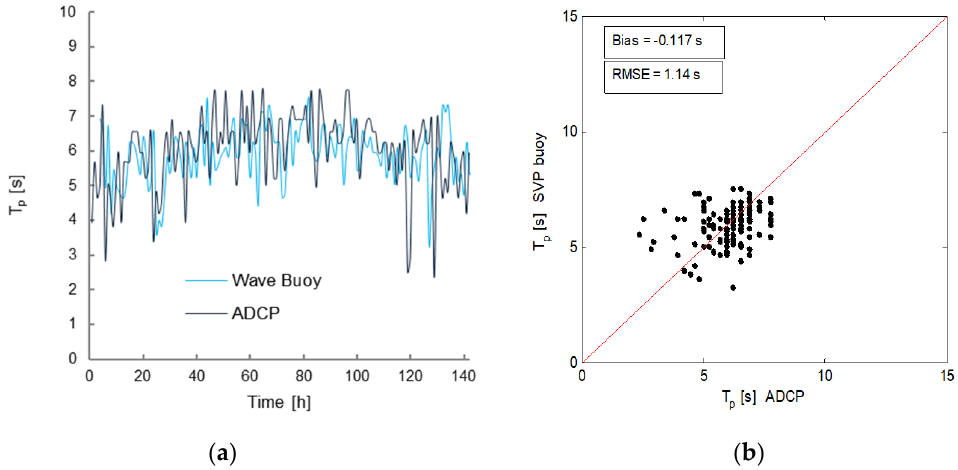
Figure 12. ( a ) Data series of the peak period T p measured with the DWSD-B buoy and the ADCP-B (from 12 May to 18 May 2016); ( b ) comparison of the peak period T p between the two instruments.